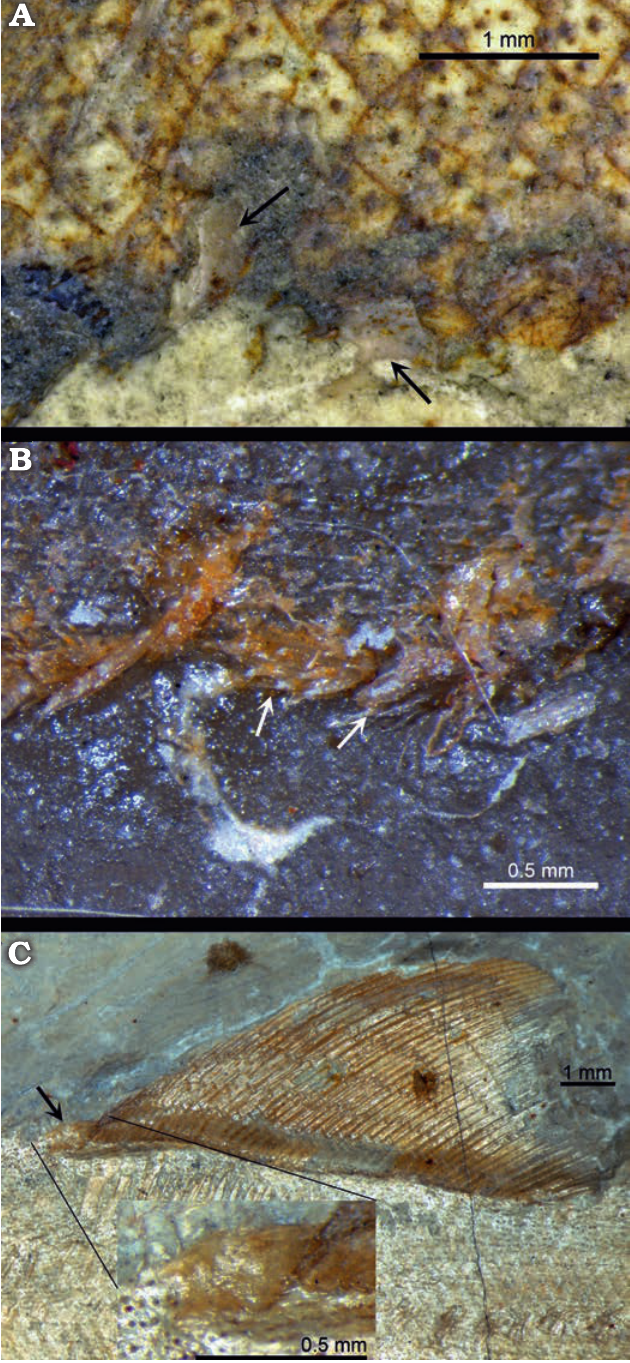
Fig. 5. Distinct scutes and scales (indicated with the arrows) in the chon- drostean fishes Coccolepis bucklandi Agassiz, 1843 (A), and Coccolepis solnhofensis sp. nov. (B, C) from the Titho nian, Upper Jurassic of the Solnhofen Lagerstätte, Bavaria, Germany. A . MHNN-FOS 361 (holotype), fragments of preanal scutes (arrows). Photograph courtesy of Thierry Malvesy (MHNN). B . SNSB-BSPG 1904 I 19 (holotype), preanal scales (arrows). C . SNSB-BSPG 1986 XV 112, predorsal scute